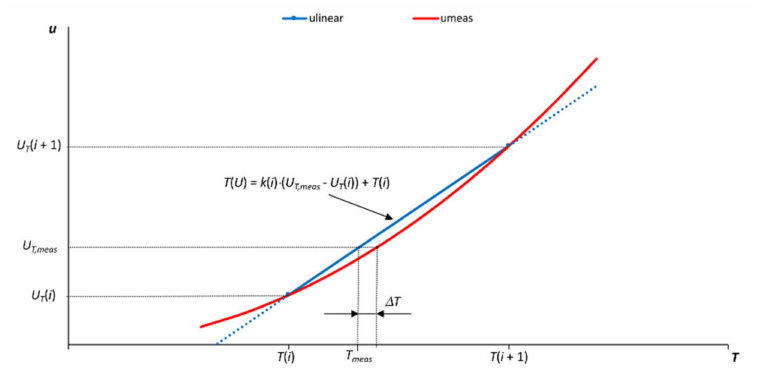
Figure 6. Linear interpolation principle.